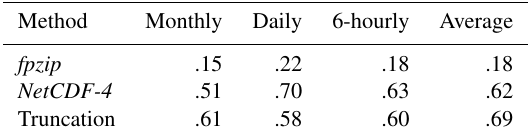
Table 1. Impact in terms of compression ratios (CR) of lossy com- pression with fpzip , lossless compression with NetCDF-4 , and sim- ple truncation for a CESM-LE ensemble member.